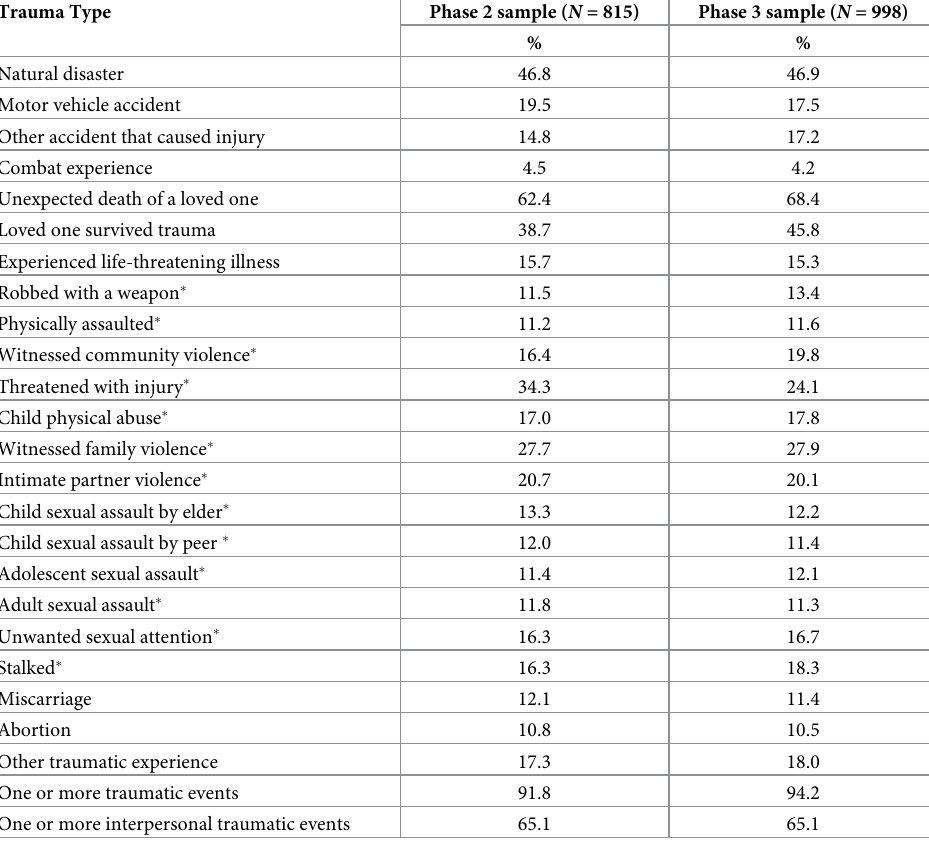
Table 1. Rates of exposure to lifetime potential trauma in Phases 2 and 3 non-clinical